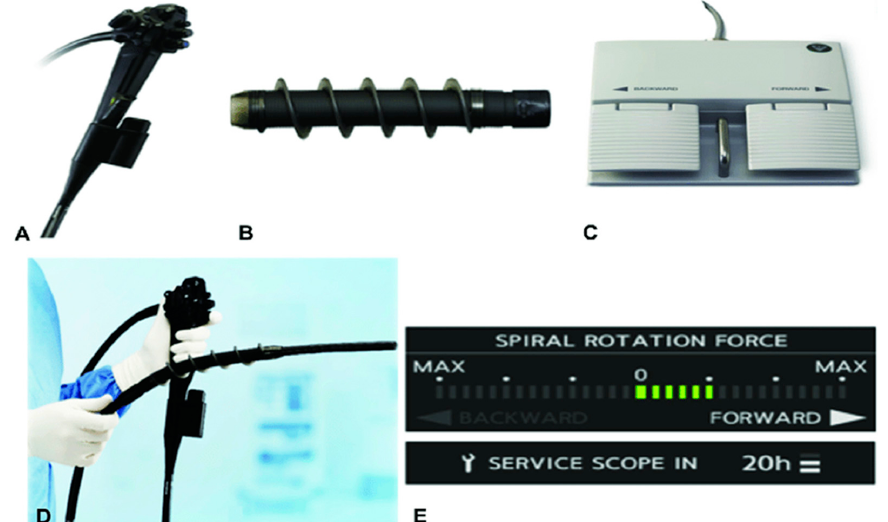
Figure 1. ( A ) Integrated motor in motorized spiral enteroscope. ( B ) Power spiral tube. ( C ) Foot switch with forward and backward pedals. ( D ) Power spiral enteroscope. ( E ) Force gauge on power spiral control unit for visual indication of the rotational direction. Pictures courtesy of Olympus Corp, Tokyo, Japan.